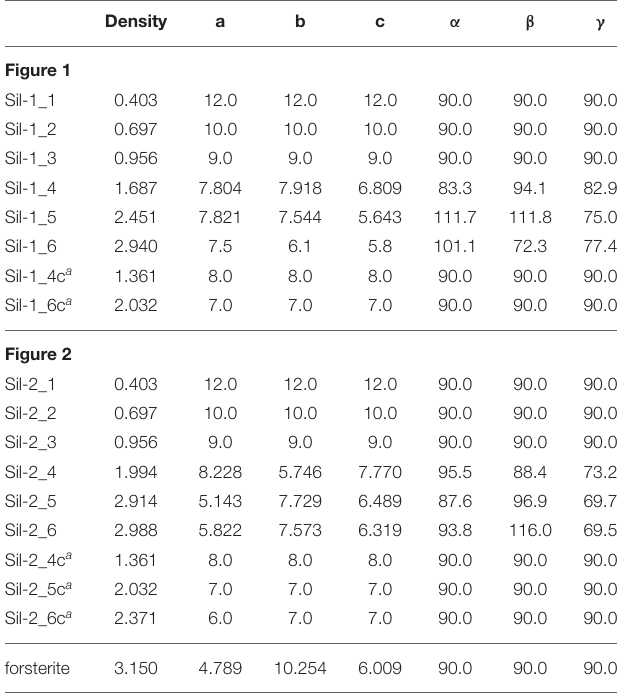
TABLE 1 | Densities (in g cm − 3 ) and lattice cell parameters (distances in Å and angles in degrees) of the periodic silicate structures shown in Figures 1 , 2 .